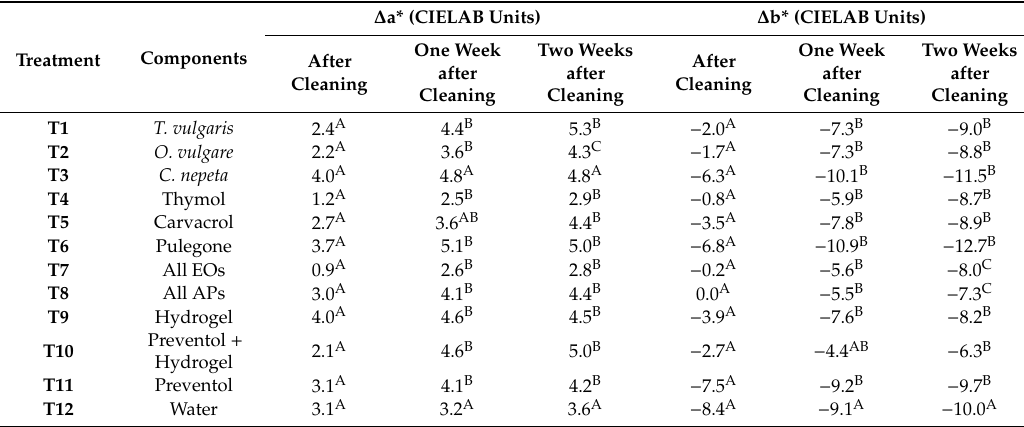
Table 2. Changes in the green-red color component ( ∆ a*) and blue-yellow color component ( ∆ b*) in the treated samples throughout the study period. Di ff erent superscript letters in each row indicate significant di ff erences ( p ≤ 0.05) in relation to the di ff erent stages of the sample’s treatment for a given partial color di ff